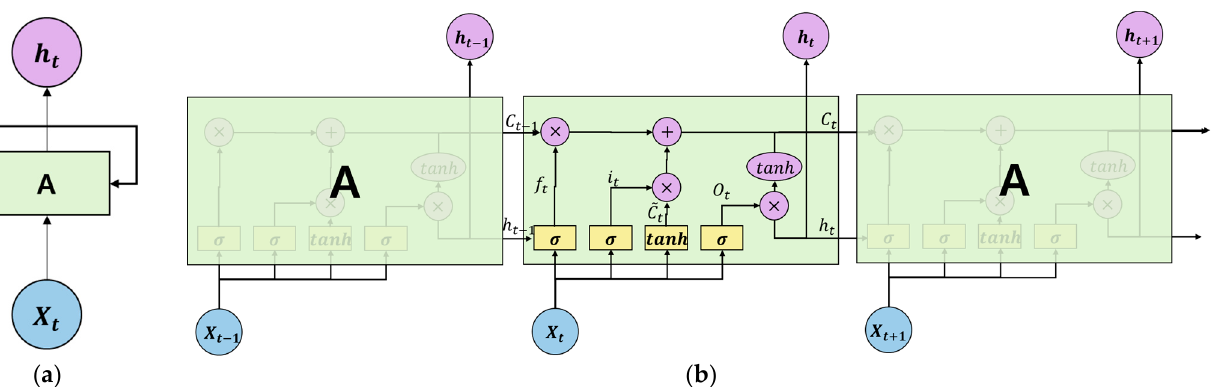
Figure 1. Structure of simple RNN and LSTM models: ( a ) RNN architecture; ( b ) LSTM architecture.